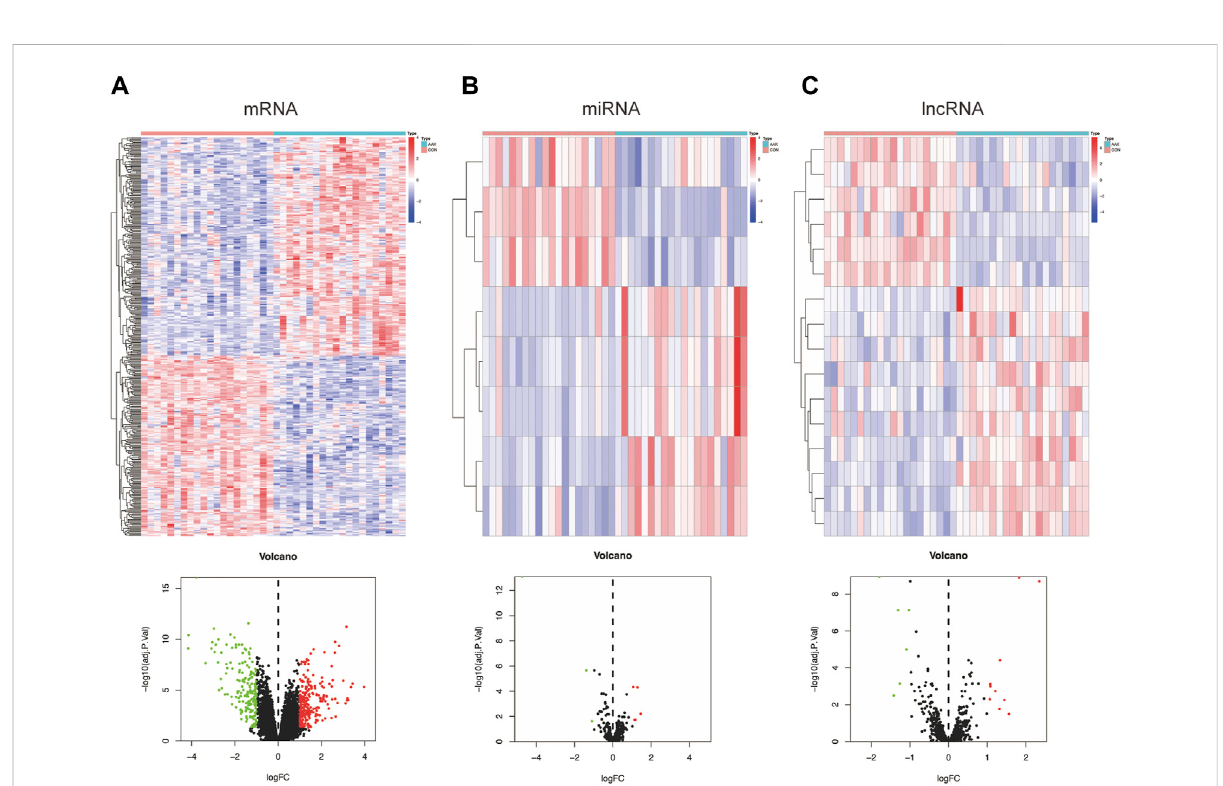
FIGURE 2 Differentially expressed genes between the AAK group and the control group. (A) Heatmap and volcano plot of differentially expressed mRNAs betweenAAKandcontrolgroup. (B) HeatmapandvolcanoplotofdifferentiallyexpressedmiRNAsbetweenAAKandcontrolgroup. (C) Heatmapand volcano plot of differentially expressed lncRNAs between AAK and control group. Red points represent up-regulated genes. Green points represent down-regulated genes. Black points represent genes with no signi fi cant difference; AAK: aniridia-associated